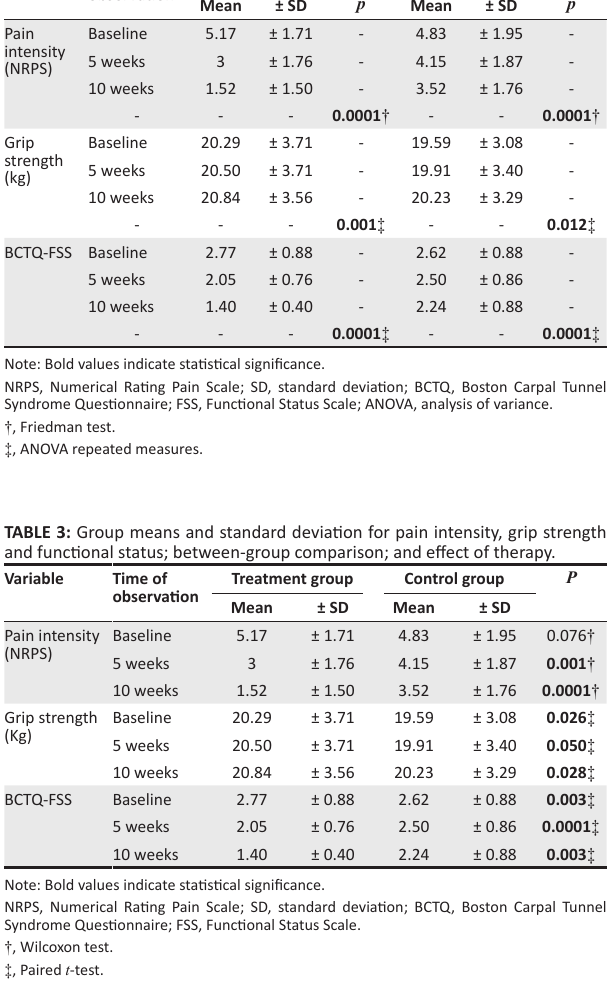
strength and functional status at different time intervals in each group. Variable Time of Treatment group Control group observation